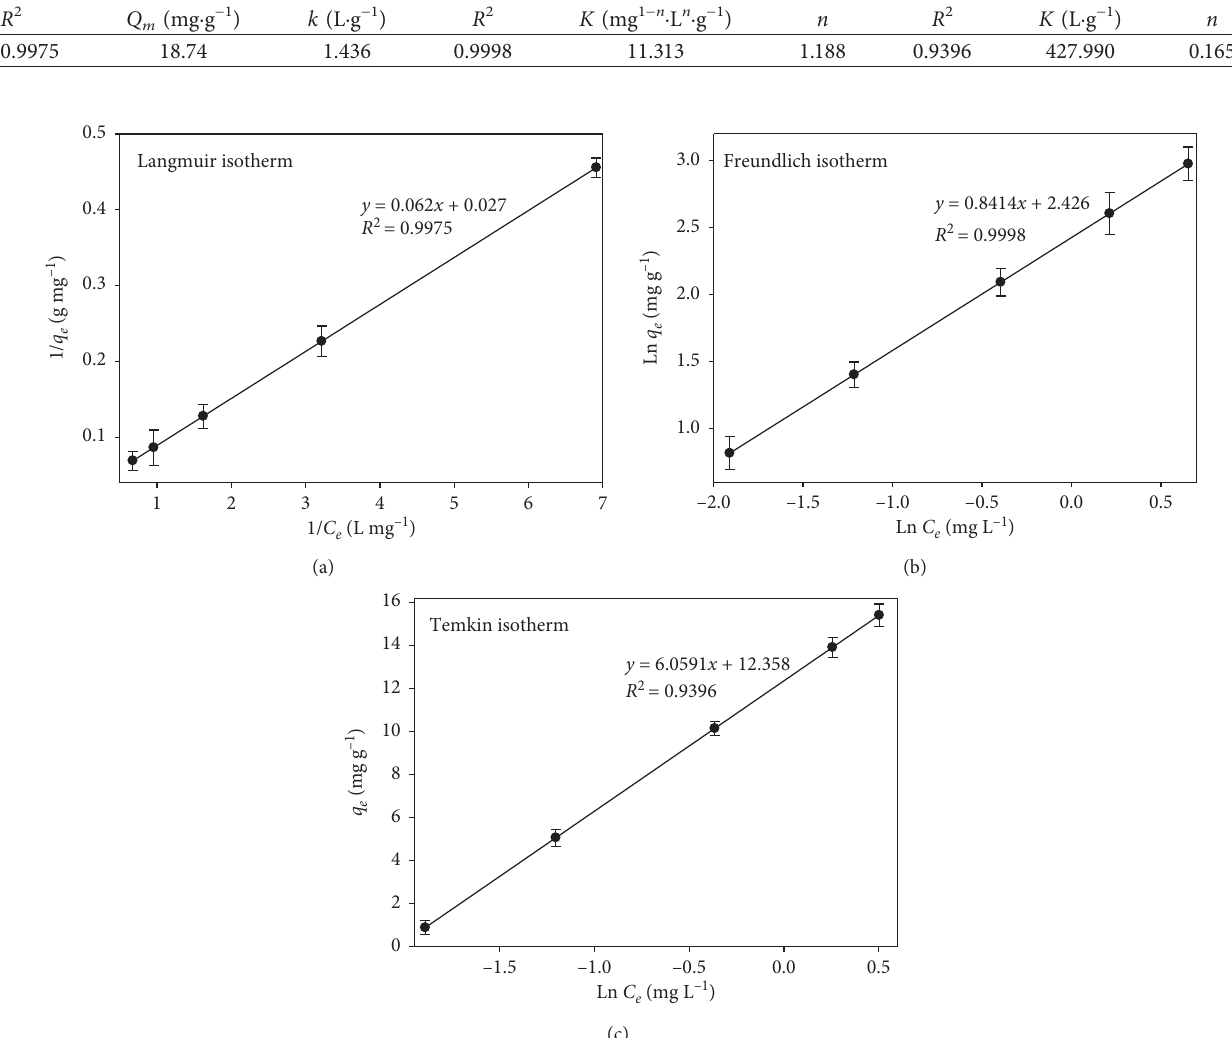
Table 1: The isotherm adsorption constant and correlation of Langmuir, Freundlich, and Temkin adsorption of acid red 73 by rice wine lees. Langmuir parameters Freundlich parameters Temkin parameters